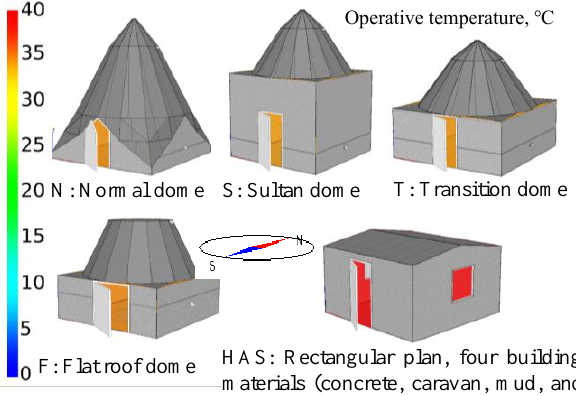
Figure 7. Different simulation models in IDA ICE illustrating the operative temperature during the hottest day of the year (21 Jun) at 16:00.